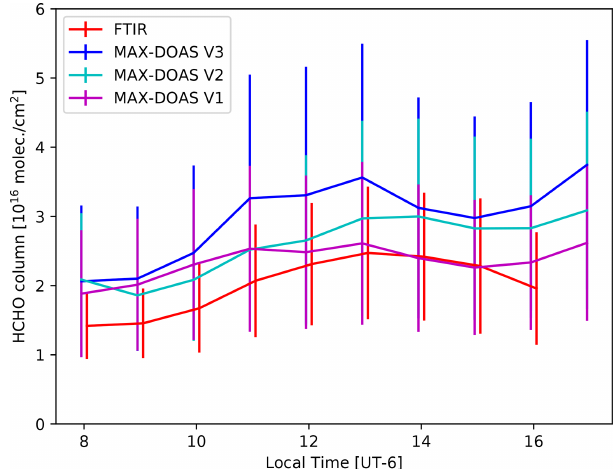
Figure 2. Diurnal cycle from hourly averaged HCHO VCDs from FTIR (red), MAX-DOAS V3 (blue), MAX-DOAS V1 (magenta) and MAX-DOAS V2 (cyan) measurements at UNAM. Vertical lines represent the standard deviation of all conducted measurements dur- ing that hour.